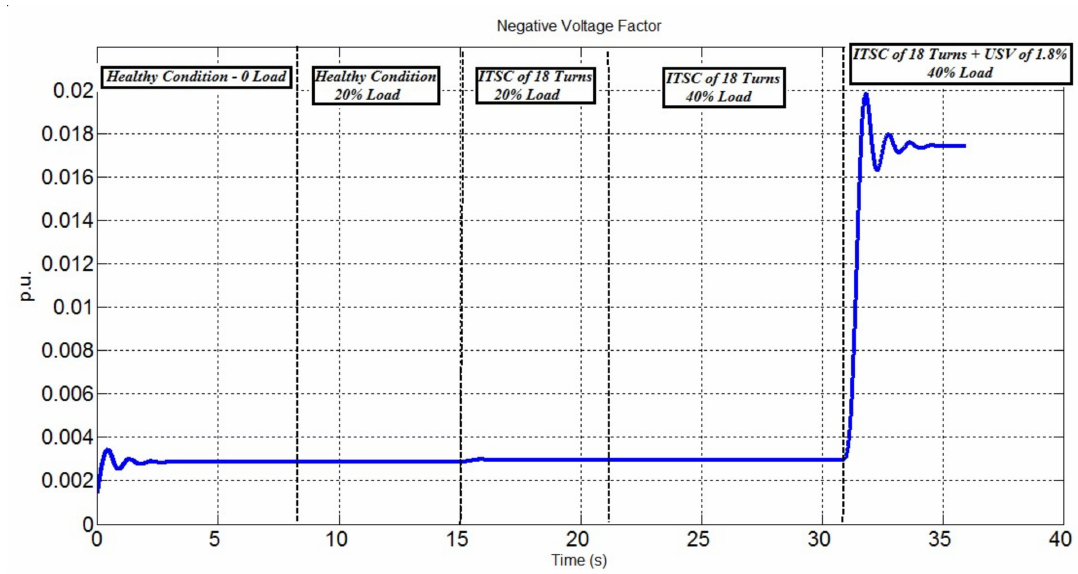
Figure 12. Time evolution of the NVF under different operating